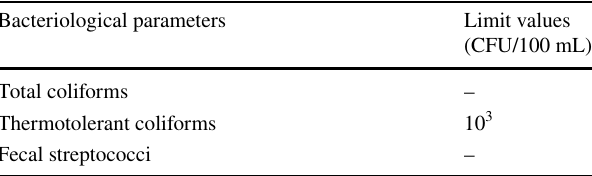
Table 3 Bacteriological parameters of treated water according to WHO (1989) (Benyagoub et al. 2018a) Bacteriological parameters